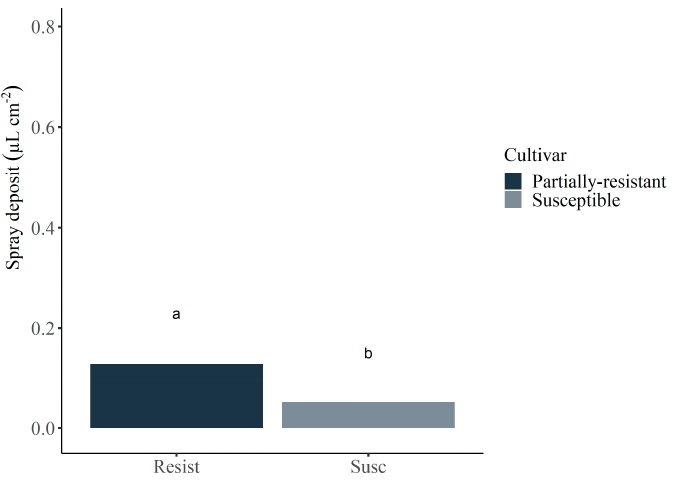
Figure 9. Mean deposit values ( µ L cm − 2 ) that were collected in the lower region of the soybean canopy of different soybean cultivars in the first application of Field 2. The means followed by the same letter did not differ by the Tukey’s test at 5% probability ( p < 0.05).